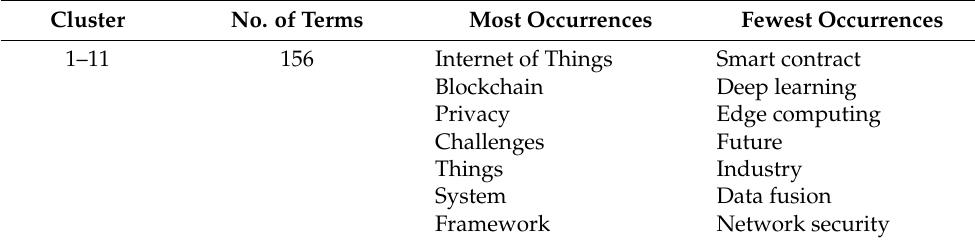
Figure 4. Bibliographic map based on VOSviewer. Table 4. Co-occurrence of terms of research related to IoT on WOS